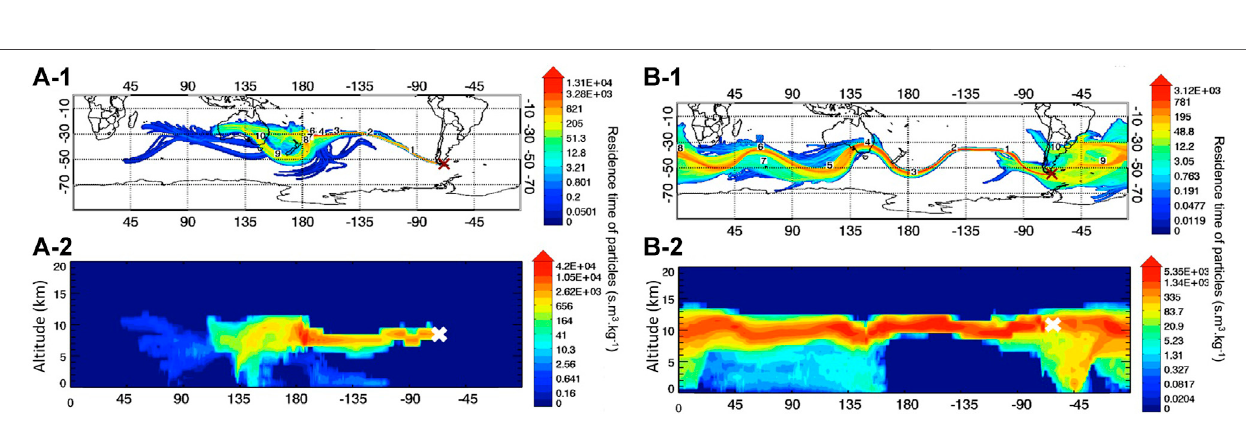
FIGURE 2 | FLEXPART 10-day back trajectories (total column), originating from the respective points (as shown in Figure 1 ). (A1) and (B-1) correspond to an integration of the trajectory positions over the whole altitude range (surface to 45 km altitude). (A-1) Trajectories initialized at point a: 12/11, 11 h 25 (UTC), 53.68 ° S, 68.60 ° W, 9 km, (B-1) point b: 12/11, 11 h 35 (UTC), 54.86 ° S, 68.18 ° W, 11.18 km. The red cross (South Argentina) represents the initialization point of the back- trajectories. Numbers indicate the number of days along the trajectories. (A-2) The vertical view of the back trajectories respective to (A-1) and (B-2) respective to (B-1)